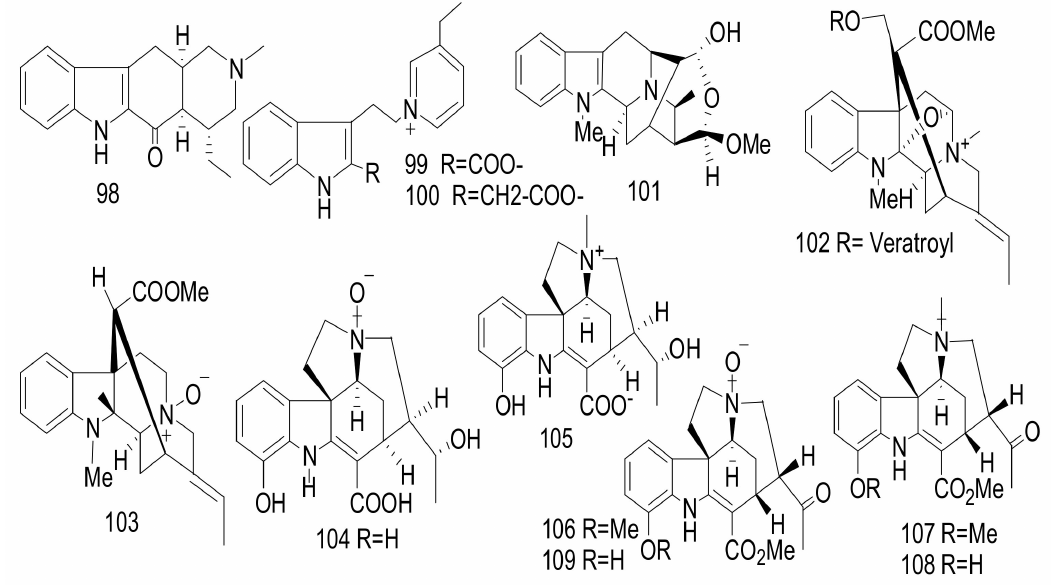
Figure 13. Compounds 98 – 109